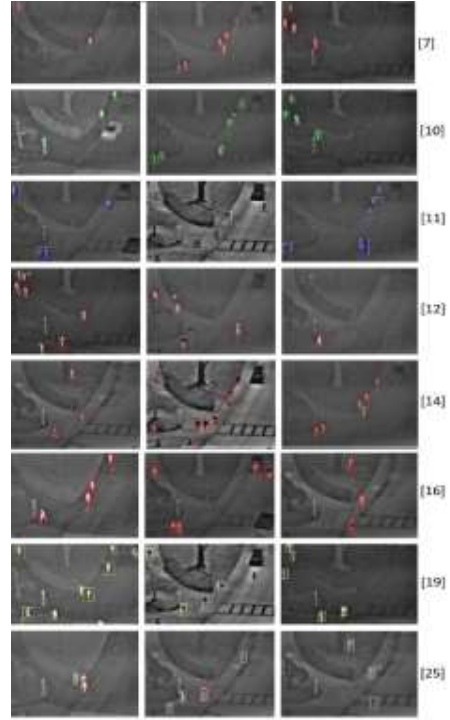
Figure 29. Samples of pedestrians' detection in database 1 for related works.